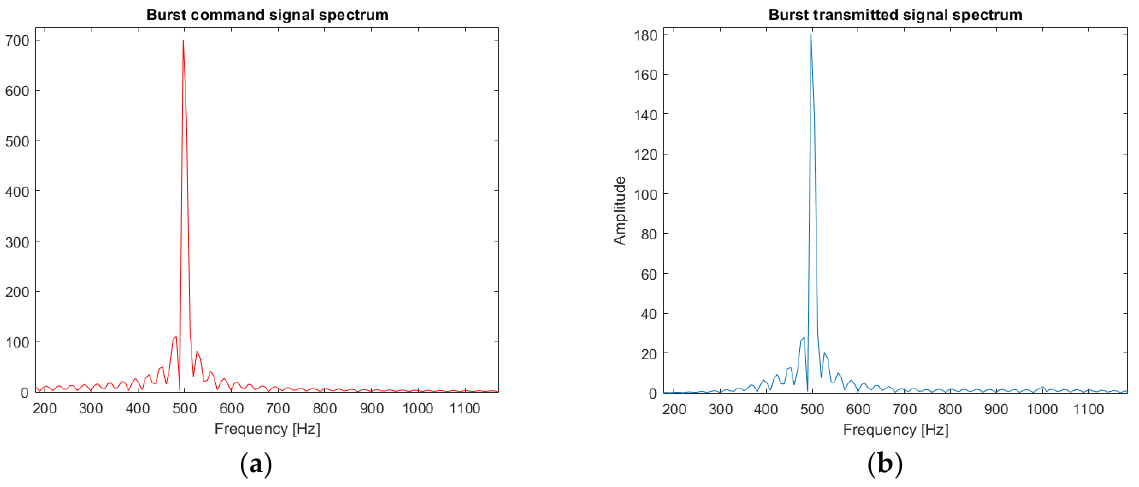
signal; ( b ) experimental source signal sent by the loudspeaker through the pipe.